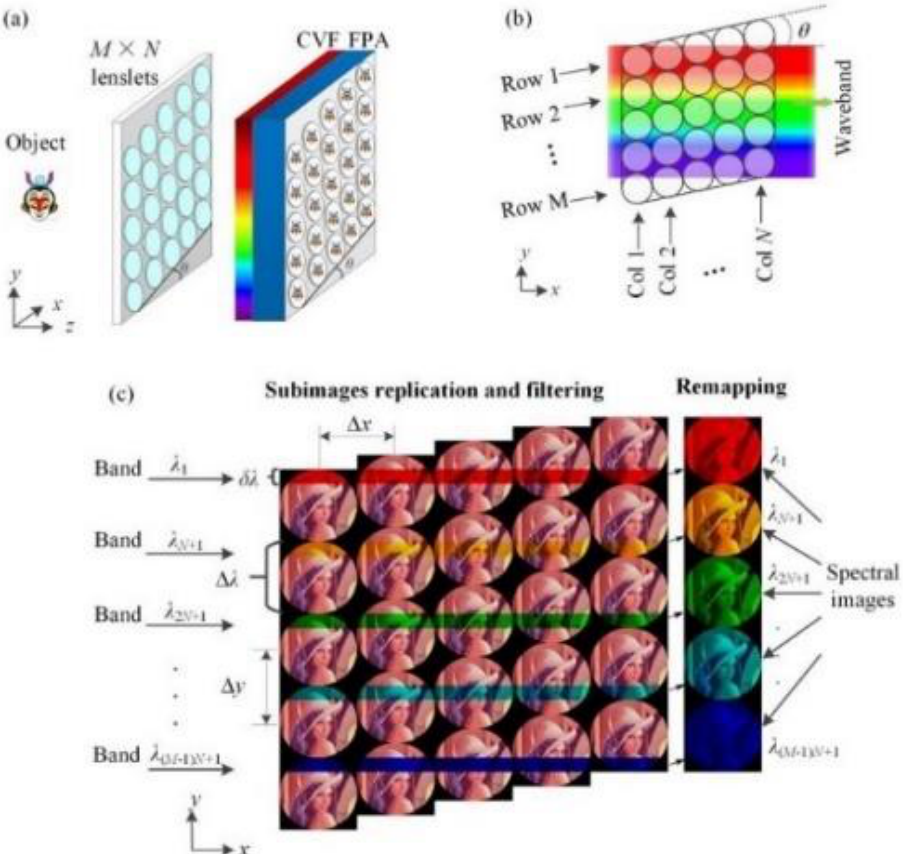
Figure 37. ( a ) Schematic of the ORRIS system. ( b ) An angle θ exists between the lenslet row and waveband directions and ( c ) the filtering process of the replicated sub-images and reconstruction of the spectral images.